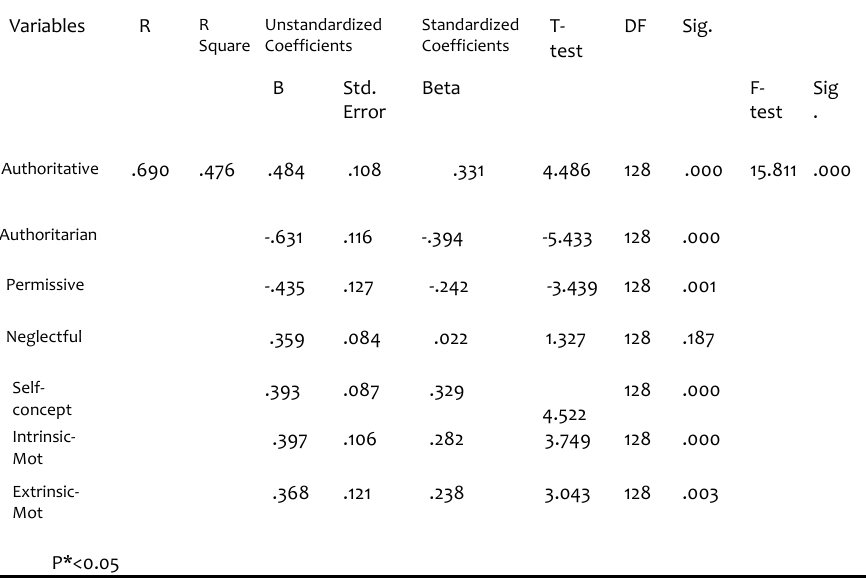
Table 4. Multiple regression of predictor variables on students’ academic achievement